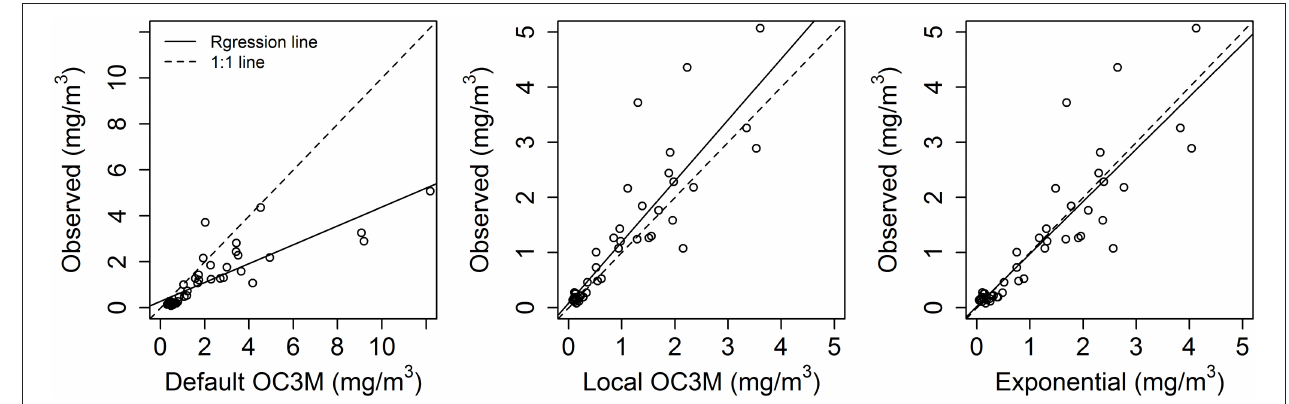
FIGURE 7 | Default (global Case 1) and local model predictions vs. 6h averaged in situ HAWQi (Hawke Bay water quality information monitoring buoy) chlorophyll- a concentrations using test dataset for the three different model approaches. Note that a different scale is used for the global Default OC3M